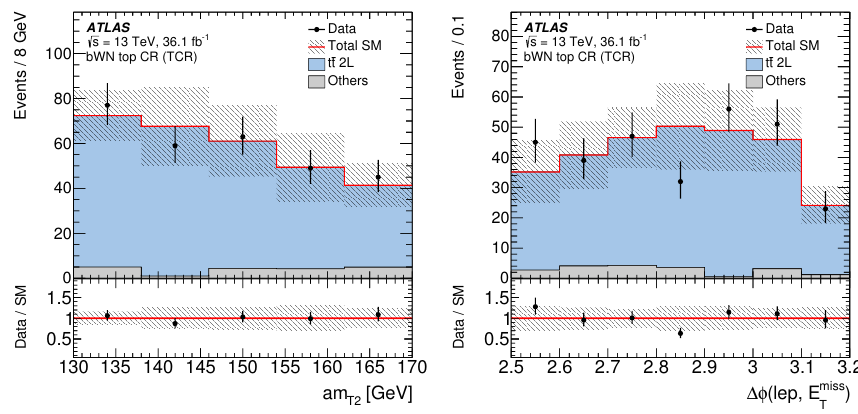
Figure 11 . Kinematic distributions in the bWN top control region (TCR): (left) am T2 and (right) (cid:1) (cid:30) ( ‘; ~p miss ). The t (cid:22) t process is scaled by a normalisation factor obtained in the corresponding T control region. The category labelled ‘Others’ stands for minor SM backgrounds that contribute less than 5% of the total SM background. The hatched area around the total SM prediction and the hatched band in the Data/SM ratio include statistical and experimental uncertainties. The last bin contains over(cid:13)ows.